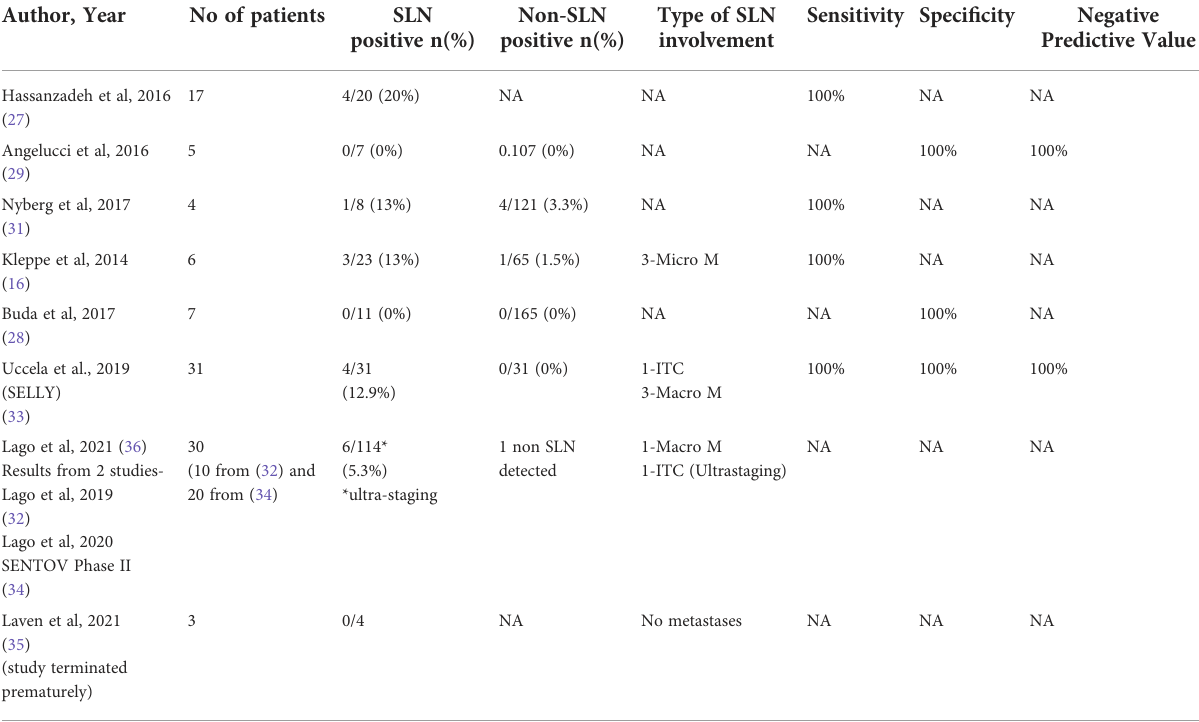
TABLE 2 Lymph node characteristics in epithelial ovarian cancer patients after SLN mapping and systemic lymphadenectomy (N=8). Author,